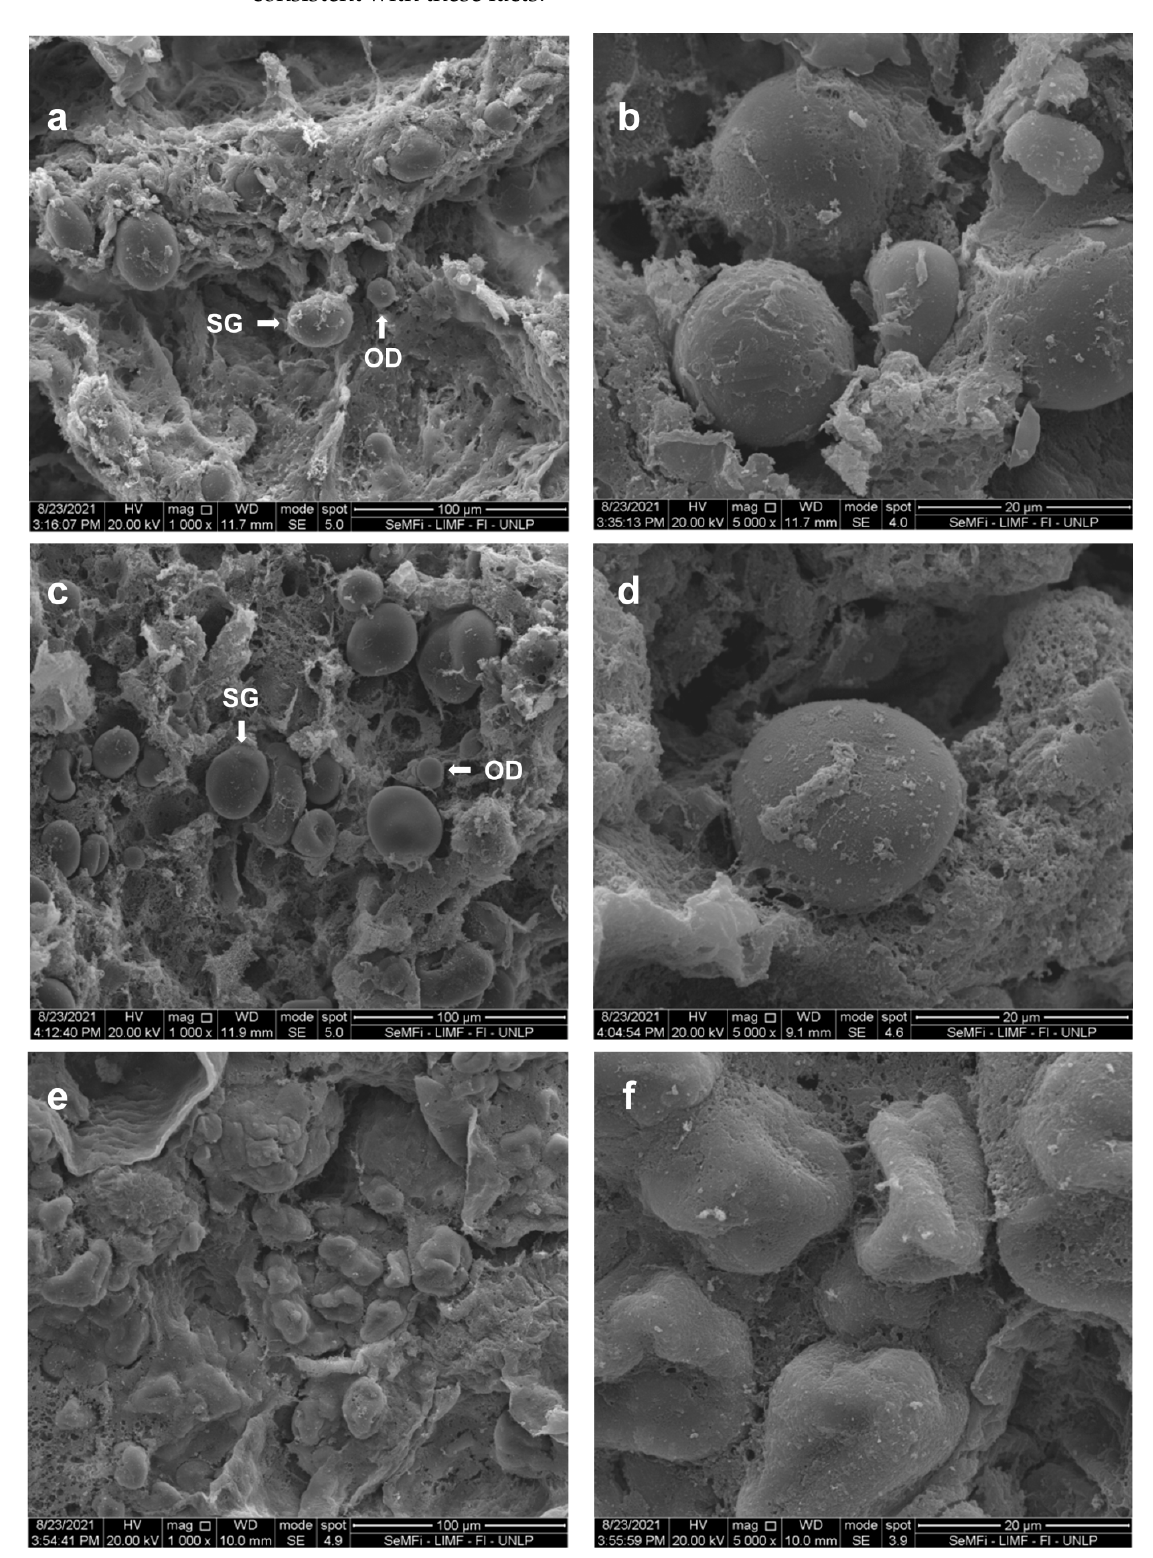
Figure 5. Scanning electron micrographs of the optimized BF-burger: raw ( a , b ); cooked—center ( c , d ) and surface ( e , f ). OD—oil droplet; SG—starch granule.